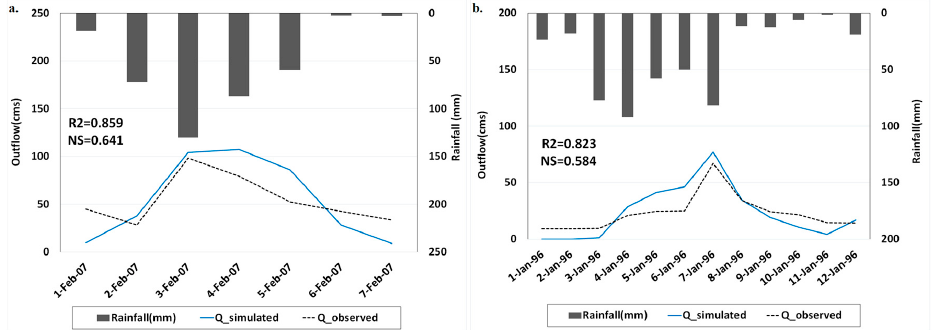
Figure 3. Results of the ( a ) calibration, and ( b ) validation of river discharge/peak flow by the HEC ‐ HMS model.